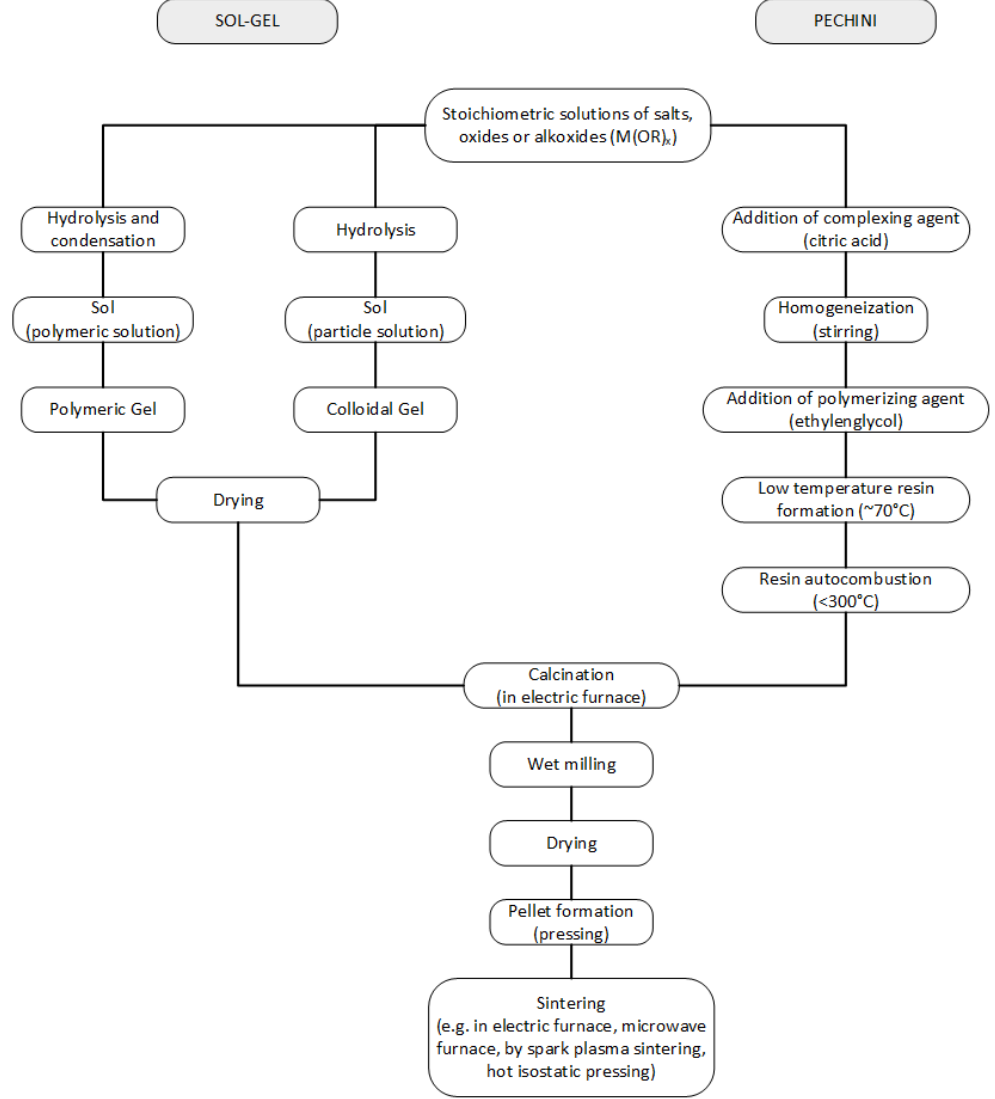
Figure 4. Flux diagram for sol ‐ gel and Pechini synthesis methods.